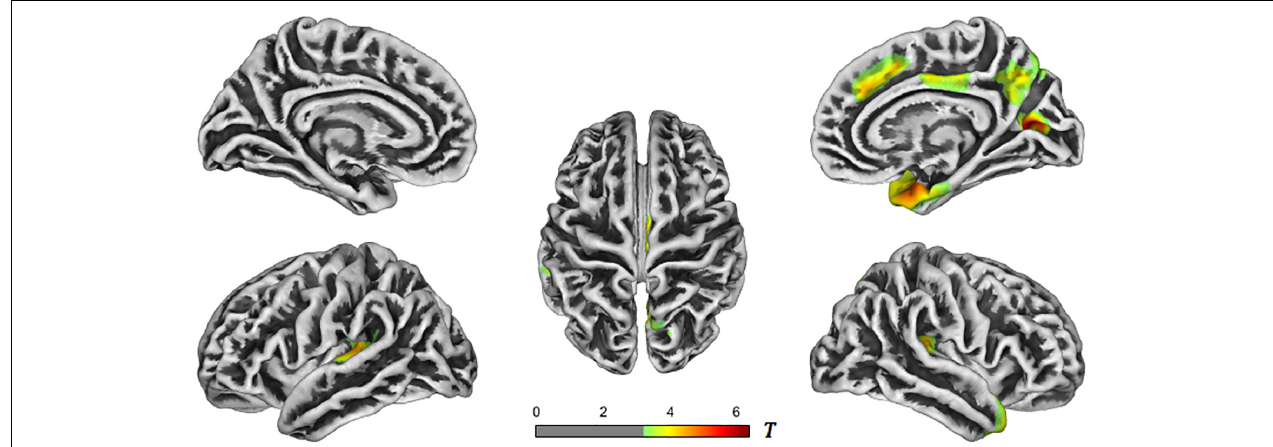
FIGURE 2 | T -value maps of brain regions with reduced cortical thickness in the AD-NC groups. The closer the color mark was to red, the more severe the atrophy [threshold-free cluster enhancement (TFCE) multiple comparison correction, P < 0.05]. AD, Alzheimer’s disease; NC, normal control.